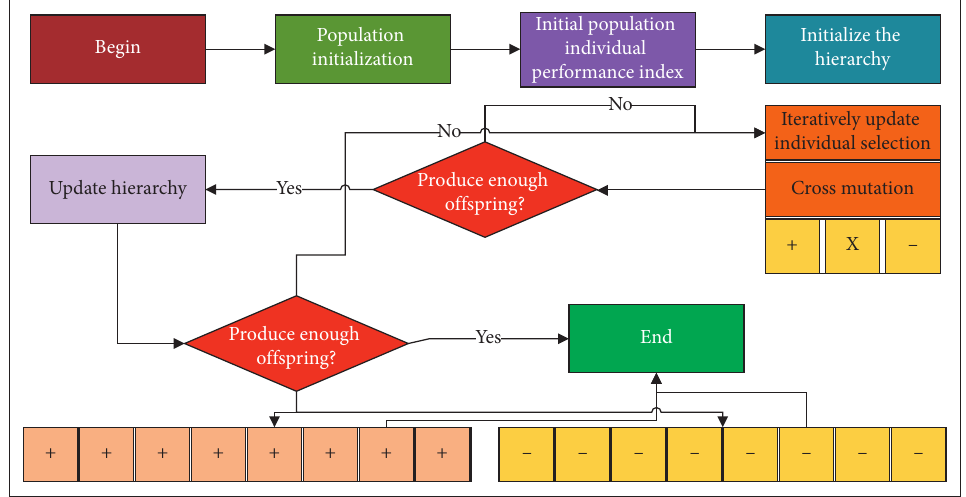
Figure 1: Improved genetic